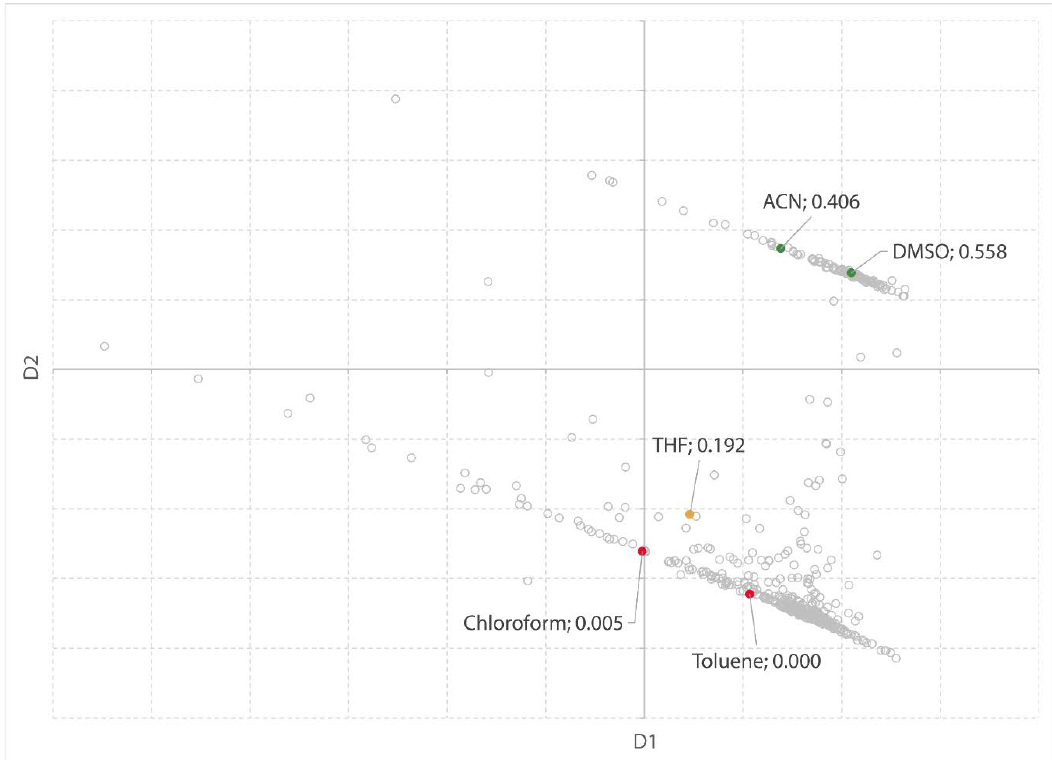
Figure 5. Keto–enol equilibrium for 2-methyl-5-phenyl-3-oxo-4-pentenenitrile.